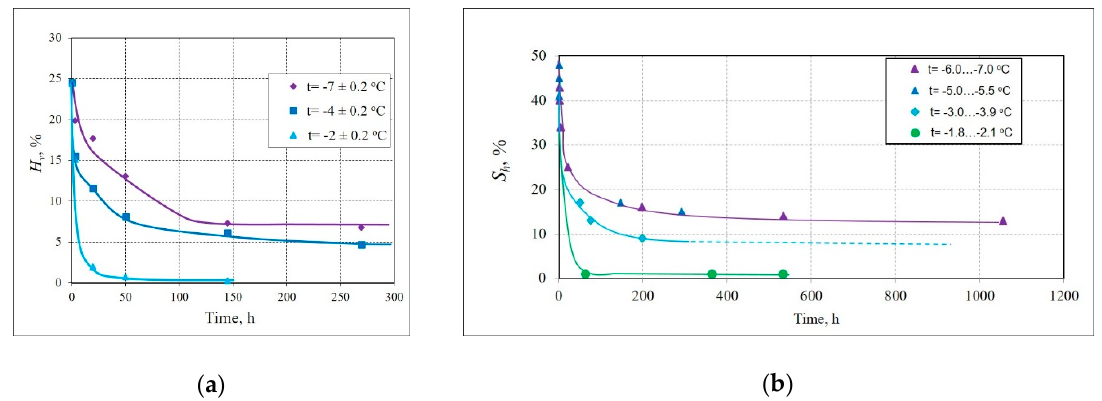
Figure 8. Kinetics of gas hydrate dissociation in frozen sand sediments at negative temperatures and atmospheric pressure. Data points (circles, triangles, squares, and diamonds) are experimental measurements, lines are approximation trends, and dashed line is the expected trend. ( a ) Fine sand-2 ( W in = 14%) [48]; ( b ) fine sand-1 ( W in = 18%) [59]. The frozen fine sand samples stored for at least 300 h at a temperature below − 5 °C and 0.1 MPa had a residual hydrate saturation of 7% and 11%, respectively. These results obtained for soil samples